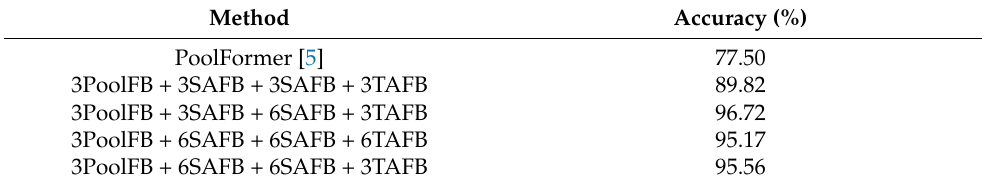
Table 5. Ablation results of the number of blocks of the proposed